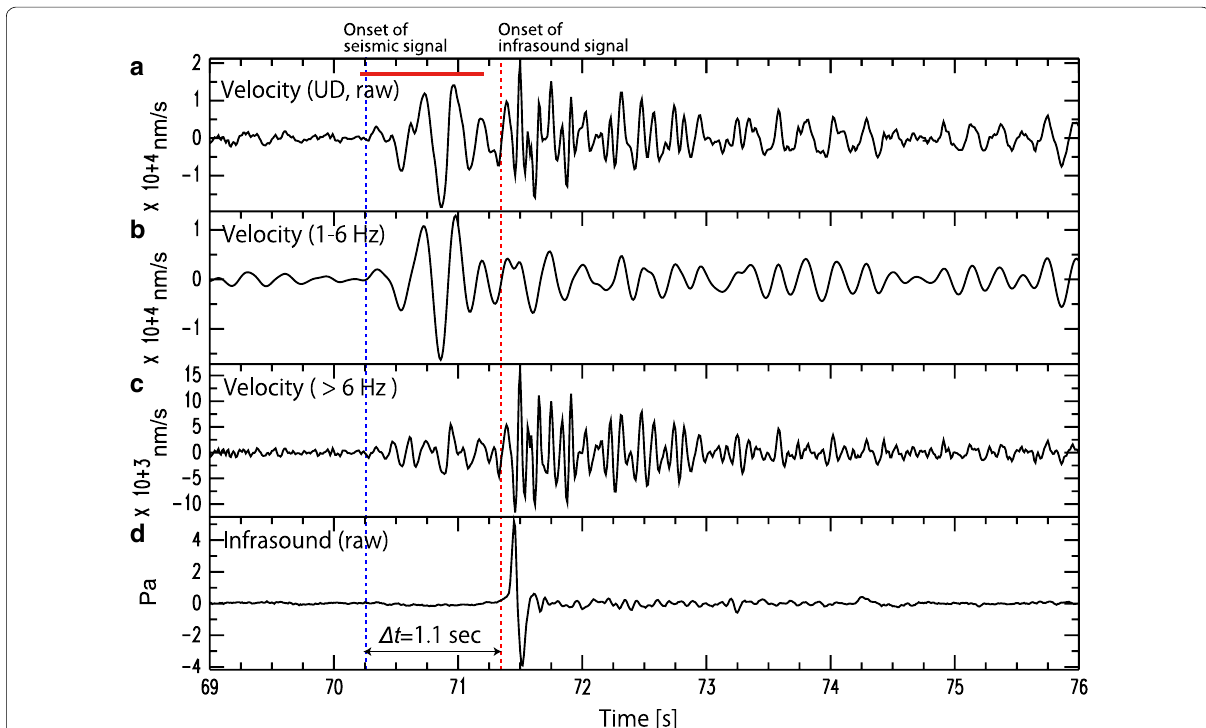
Fig. 12 Magnified plot of seismic and acoustic records within the red rectangle in Fig. 11a. a – c The raw, band-passed, and high-passed signals of the vertical component of a seismometer. d The raw signal of a microphone. The vertical blue and red lines show the onset times for the seismic signal and the impulsive infrasonic wave,